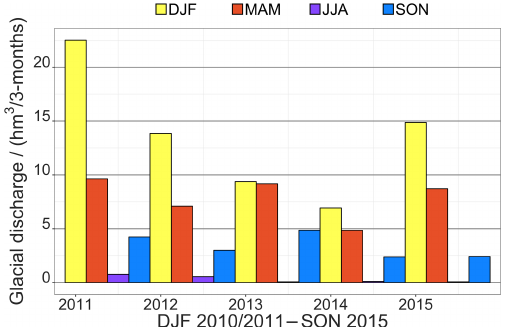
and the respective source areas (firn, ice, snow and rock).